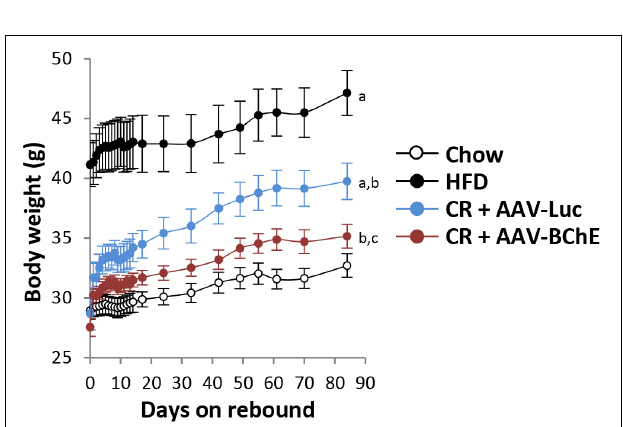
FIGURE 3 | Rebound weight gain in formerly obese mice on high fat diet after return to free access standard mouse chow. (a) Significant with respect to chow group; (b) significant with respect to HFD group; (c) significant with respect to CR + AAV-Luc group. Significance was set at P < 0.05 by two-way repeated-measures ANOVA Chen et al.